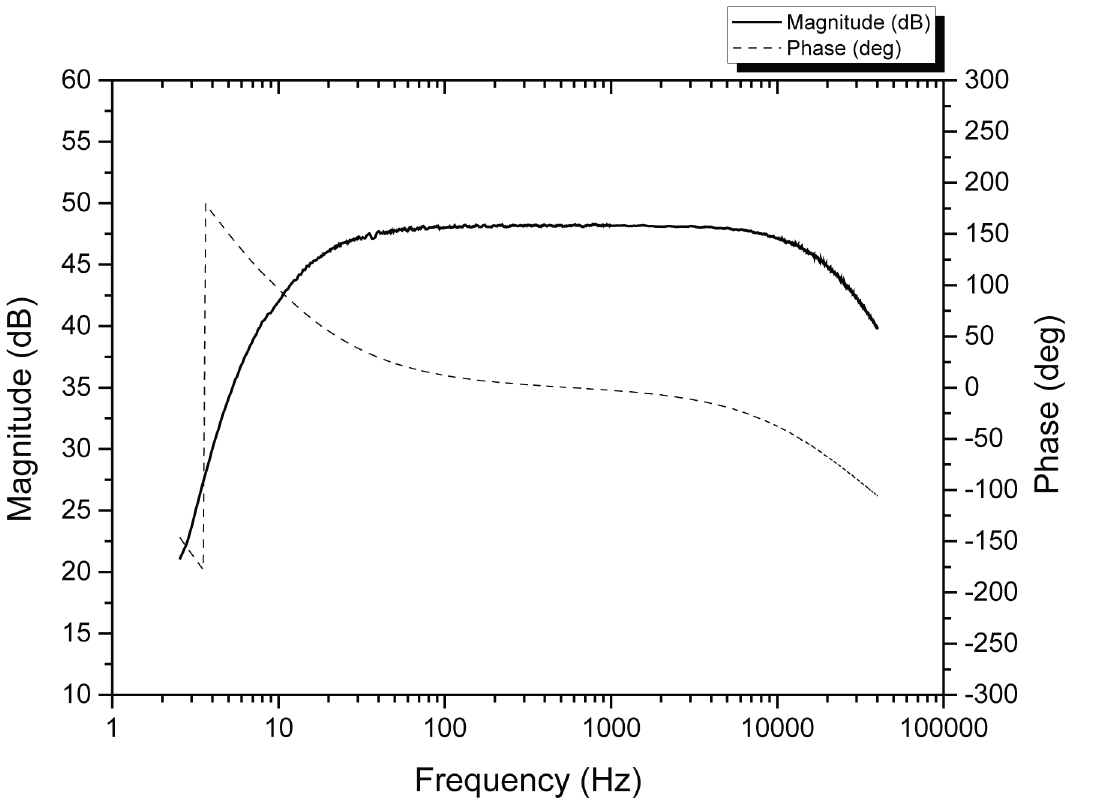
Fig 2. Experimental frequency response obtained with a particular tuning of the signal-conditioning